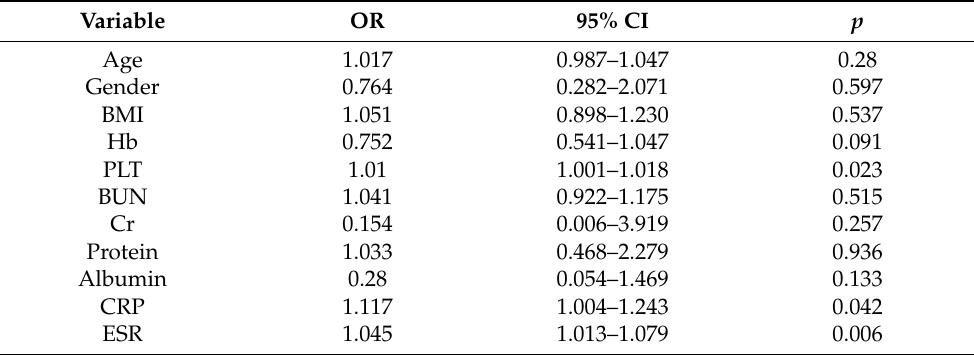
Table 3. Univariate analysis of the factors influencing the positive findings of